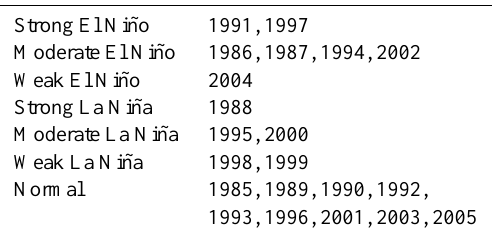
Table 1. ENSO classification from Golden Gate Weather